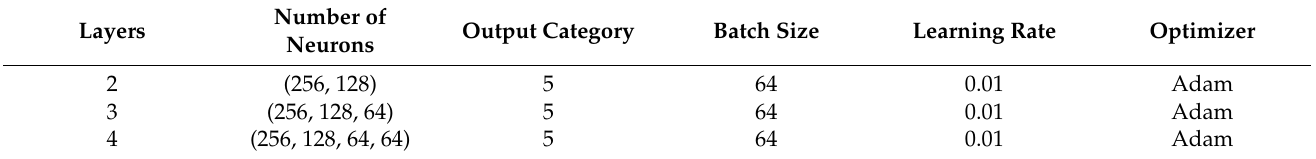
Table 1. Network Parameters of Models with Different Layers.